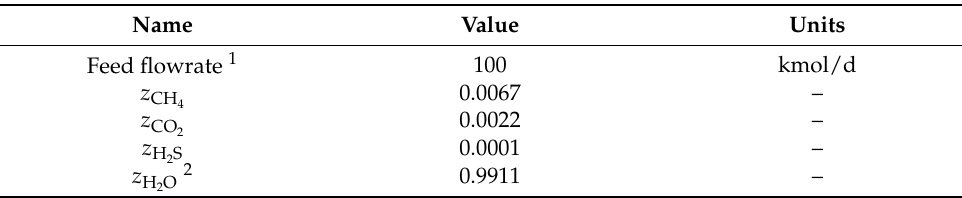
Table 2. Data about inlet composition and reactor load, shared by industrial company, already converted and ready-to-use for